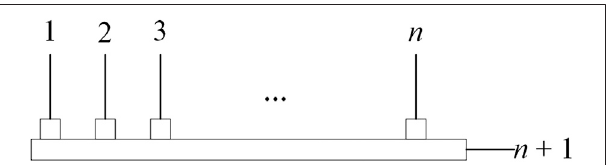
FIGURE 3 | A simpli fi ed frame-subgroup structure.